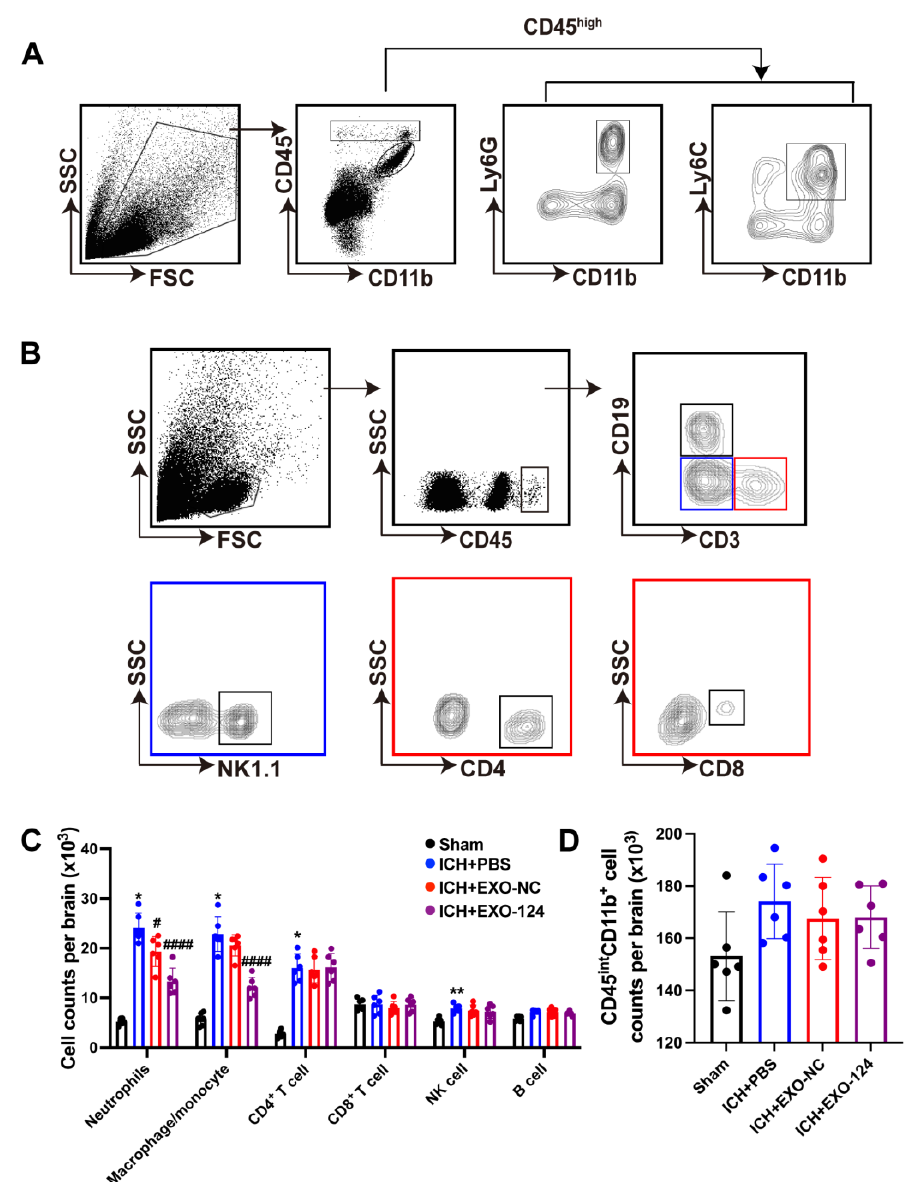
Figure 6. miRNA-124-enriched microglia-derived exosomes reduce immune cell subset infiltration into the brain after ICH. ( A , B ) Representative flow cytometry plots showing the gating strategies for brain-infiltrating immune cells, including CD4 + T cells (CD45 high CD3 + CD4 + ), CD8 + T cells (CD45 high CD3 + CD8 + ), B cells (CD45 high CD3 − CD19 + ), NK cells (CD45 high CD3 − NK1.1 + ), neutrophils (CD45 high CD11b + Ly6G + ), monocytes/macrophages (CD45 high CD11b + Ly6C + ) and microglia (CD45 int CD11b + ). ( C , D ) The bar graph shows that the infiltration of neutrophils and mono- cyte/macrophage cells was decreased in the Exo-124-treated group compared with the PBS-treated group. n = 6/group, mean ± SD. * p < 0.05, ** p < 0.01 vs. the sham group, # p < 0.05, #### p < 0.0001 vs. the ICH + PBS